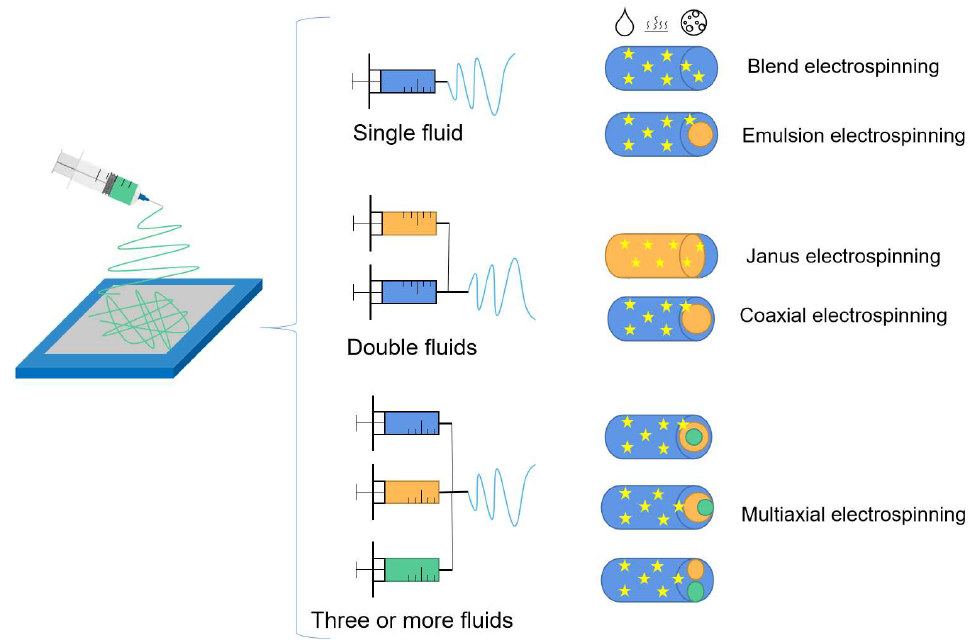
Figure 4. Electrospinning process classified by spinning head structure.